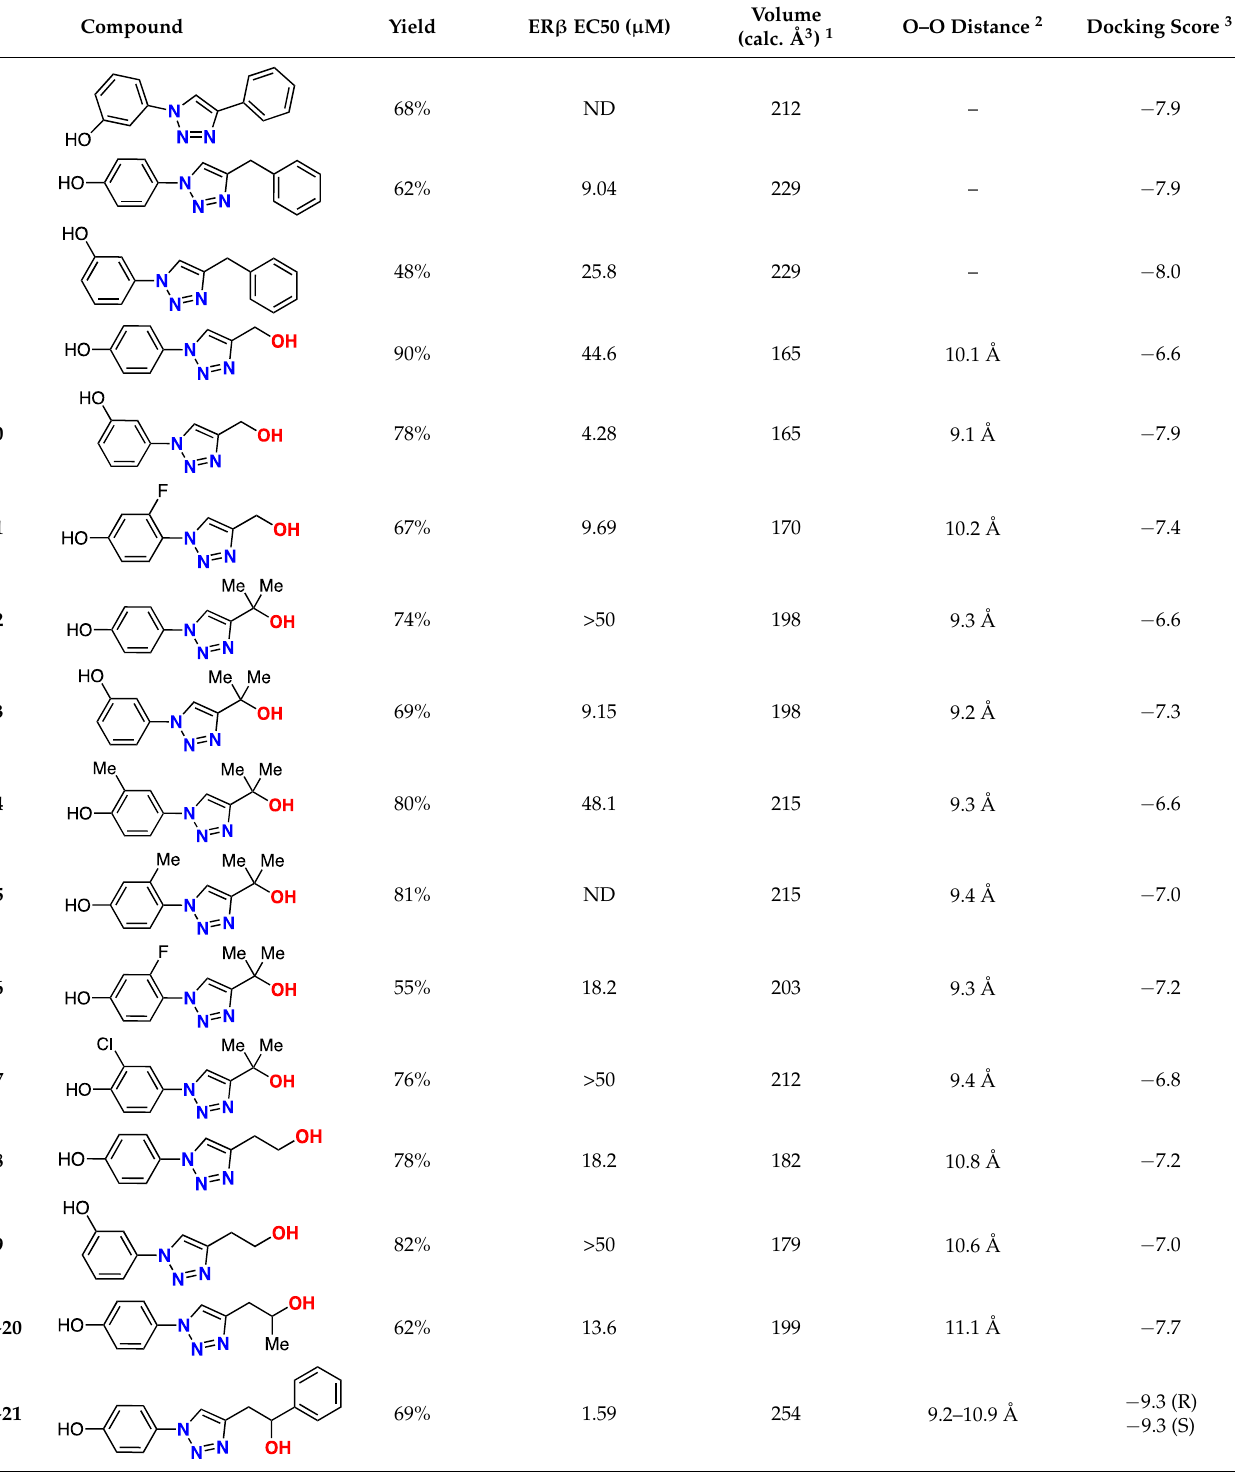
Table 1. 1,4-Disubstituted-1,2,3-triazole yields, ER β ligand displacement data and docking scores. Compound Yield